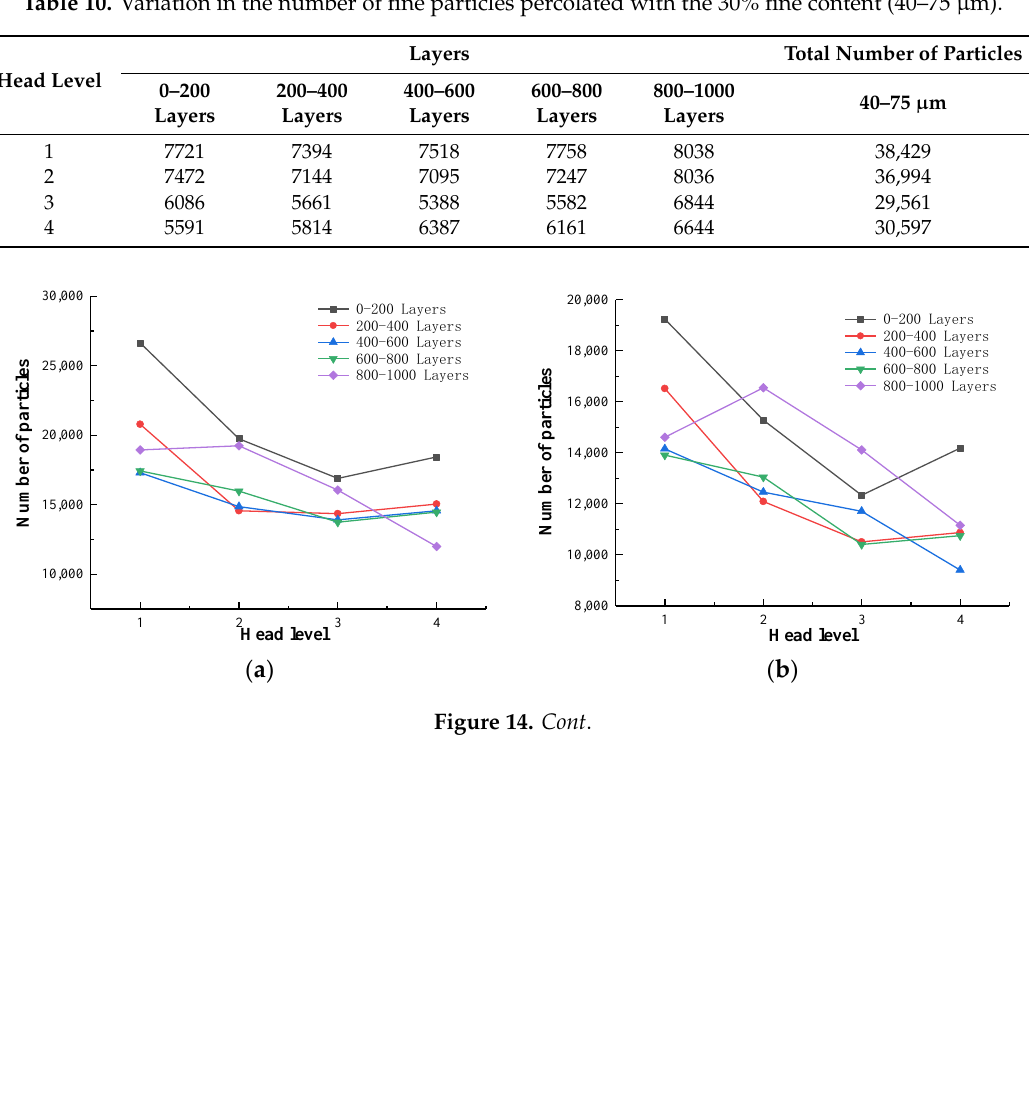
Table 9. Variation in the number of fine particles percolated with the 30% fine content (20 – 40 µm).